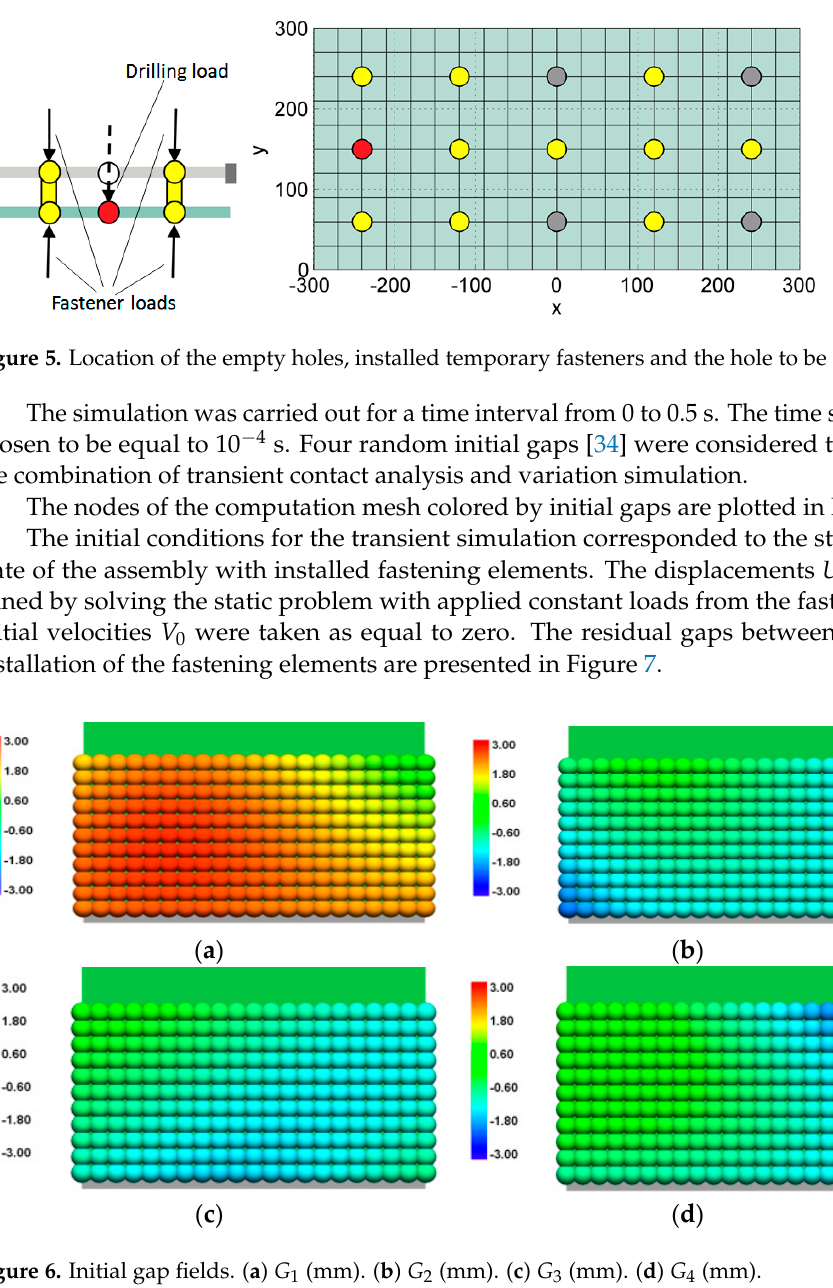
Figure 4. Model of the aircraft panel assembly. ( a ) Bottom view. ( b ) Top view.